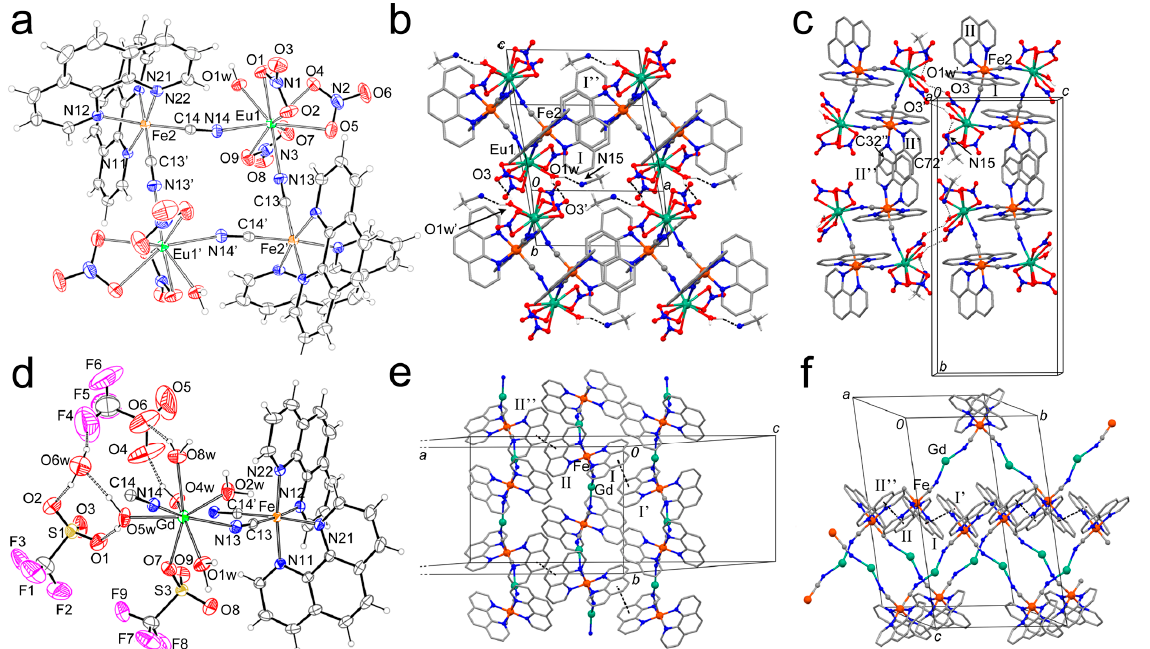
Figure 1. ( a ) Molecular drawing of 1 -Eu at the 30% ellipsoids probability level. The acetonitrile crystallization molecules have been removed for clarity. ( b , c ) Views of the crystal packing of 1 -Eu, where hydrogen bonds between water molecules, nitrate anions and acetonitrile molecules are reported as dashed bonds. The I phenanthroline moieties are regularly π -stacked with two out of three aromatic rings. The packing along b is determined by the interaction between the symmetry- related II phenanthroline groups. ( d ) Molecular drawing of 2 -Gd at the 30% ellipsoids probability level. Hydrogen bonds between water molecules and triflate anions are reported as dashed bonds. ( e , f ) Views of the crystal packing of 2 -Gd. The π -stacking between I and II phenanthroline rings is reported as dashed bonds. The triflate counteranions and the crystallization water molecules have been removed for